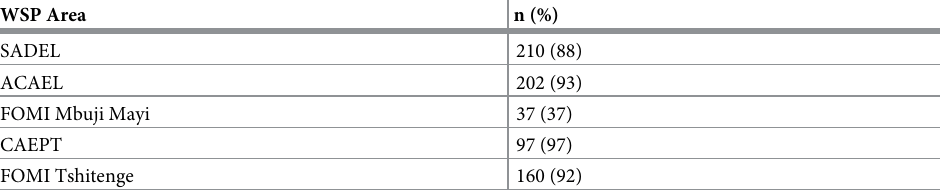
Table 1. Number (%) of households classified as water insecure by HWISE and stratified by WSP area, n =